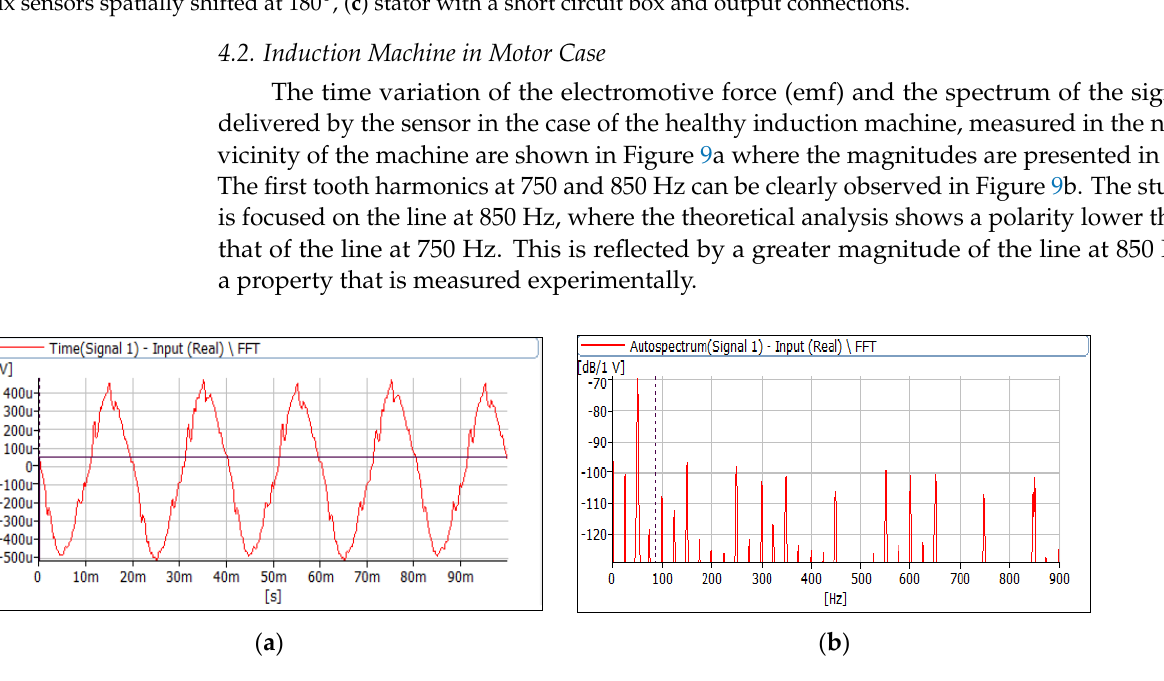
( b ) Figure 10. Harmonic components at 850 Hz under both measurement positions for healthy motor and load variation ( a ) measurement in position 1, ( b ) measurement in position 2. Figure 10 shows that a difference appears between the amplitudes of significant lines at 850 Hz for the healthy machine in positions 1 and 2. Actually, due to the real geometry of the machine, the elements that lead to the attenuation are not exactly the same all around the machine. However, as aforementioned in the analytical development, one finds the same direction of variation (positive) of this component for both positions when the machine is loaded.